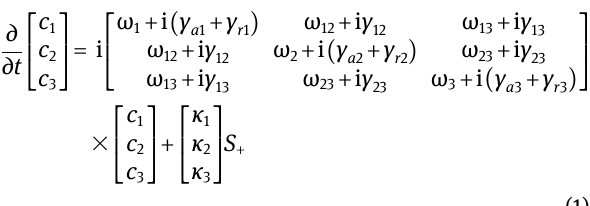
Figure 4: Integrated metasurface for the subwavelength, full-color sorting with the potential extraction of photocurrents. (a) Schematic of different-sized nanobeam arrays vertically integrated as layered metasurfaces for the effective sorting of full-visible color. (b) Absorption spectrums in each nanobeam arrays illustrating enhanced absorption and exclusive suppression of the spectrums by anti- Hermitian coupling. Solid line: finite- difference time-domain (FDTD) simulation, dashed line: theoretical line based on coupled mode theory (CMT). (c,d,e) Electric field profilesand theassociated power flow lines at the wavelength of 480 nm (c), 556nm(d),and626nm(e).Eachnanobeam array excites Mie resonance at the target wavelength of incident